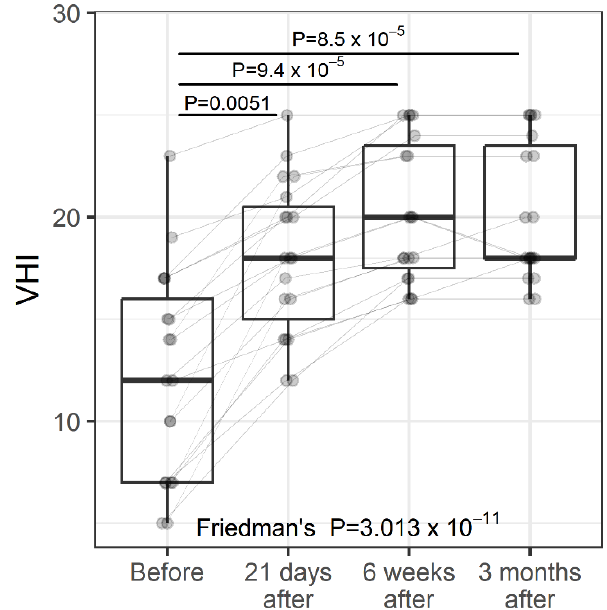
Figure 3. VHI (Vaginal Health Index) at study entry and follow-up visits (individual values and summary statistics).